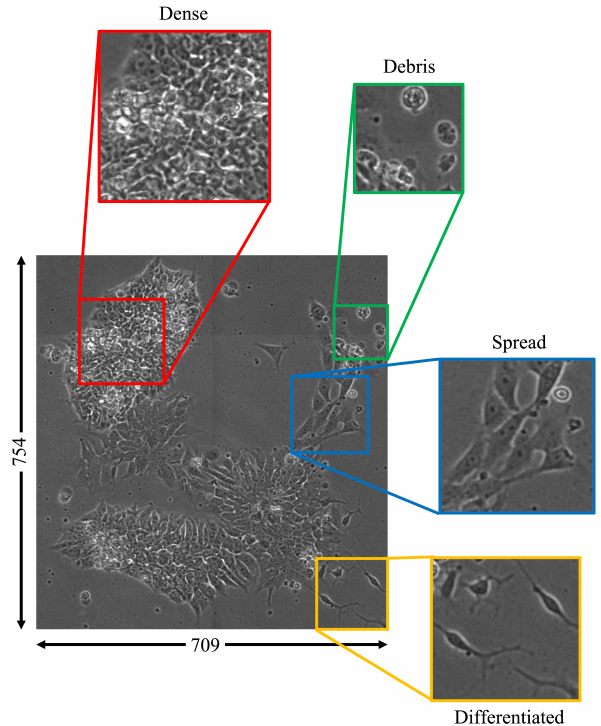
Figure 1. Image examples for four morphological classes observable in a single cell colony (debris: green; dense: red; spread: blue; differentiated: yellow). Throughout the differentiation process, various proportions of each class can be found in cell colonies with contiguous cell boundaries. Classification of these multiclass images can be performed using image